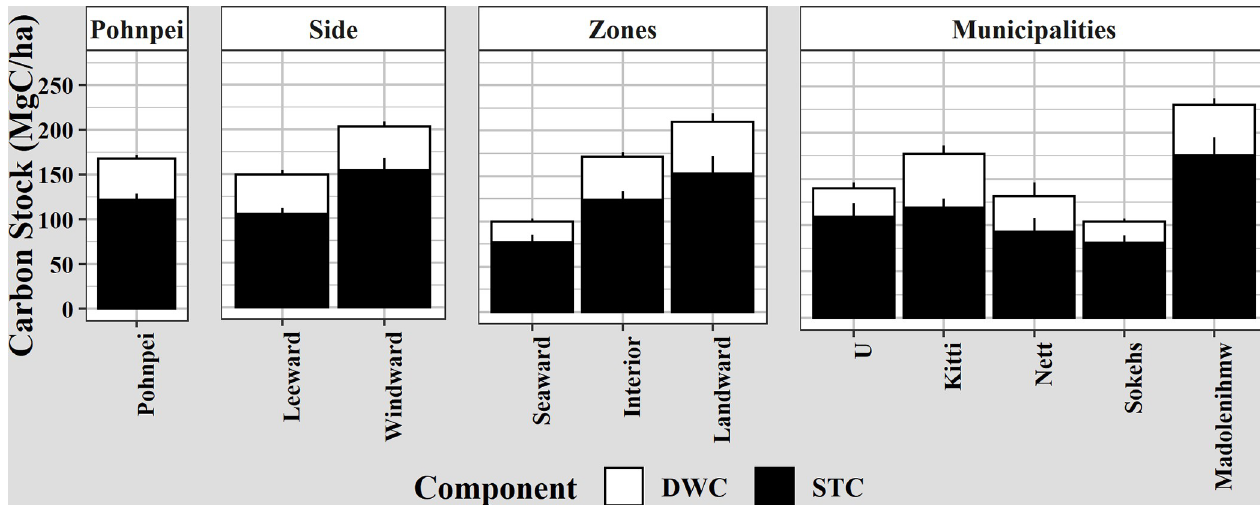
Fig 5. Carbon stock by location on Pohnpei Island. Bar graphs of mean and standard error of standing tree carbon (STC) and downed wood carbon (DWC) stock (MgC ha -1 ) by location of the field plots on the island of Pohnpei. Island sides are shown in Fig 1 and zones are discussed in the text.